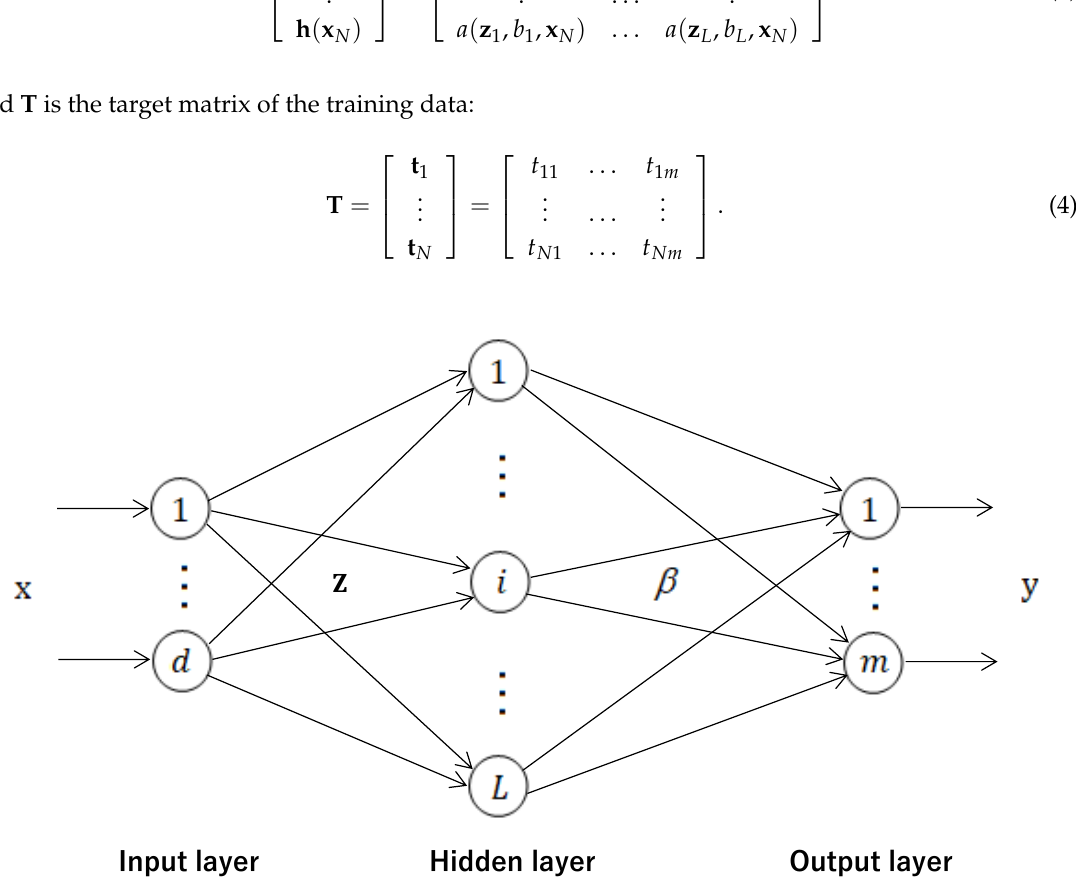
Figure 2. Architecture of the extreme learning machine